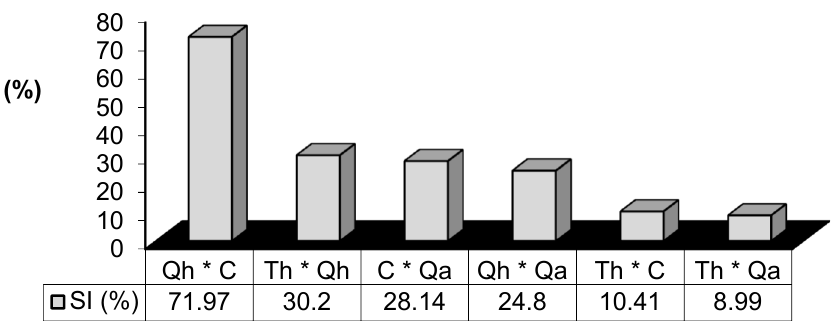
Figure 4. Interactions between the operating variables (( a ): Q h versus C ; ( b ): T h versus Q h ; ( c ): C versus Q a ; ( d ): Q h versus Q a ; ( e ): T h versus C ; and ( f ): T h versus Q a ) and their related severity index (SI%) based on the operating conditions from Table 3.